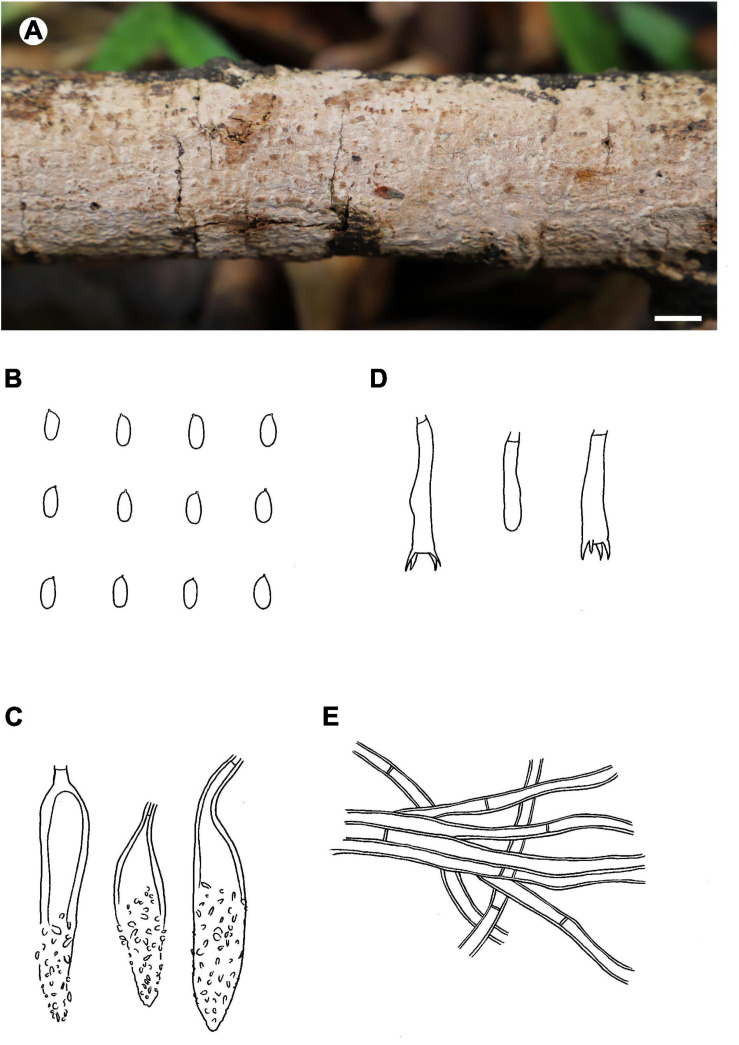
Phlebiopsis brunnea (from the holotype He 5822; scale bars: A = 1 cm, B–E = 10 μm). (A) Basidiomata; (B) basidiospores; (C) lamprocystidia; (D) basidia and basidiole; (E) hyphae from subiculum.